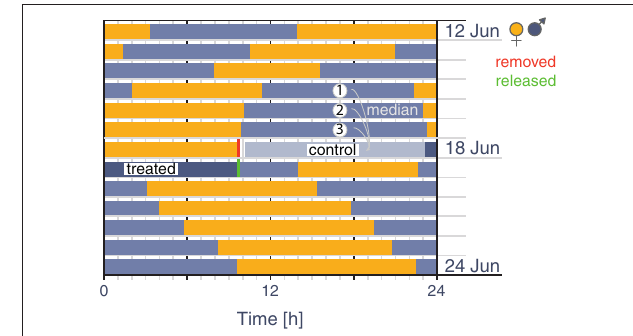
FIGURE 2 | Schematic illustration of the experimental procedure . Rectangles indicate incubation bouts of a pair (female: yellow, male: blue-gray). We removed an incubating parent (here, the female) in the middle of the incubation period (indicated by the red vertical line), shortly before we expected its partner (the focal parent; here the male) to return. After 24h we released the removed parent in the vicinity of its nest (the release time is indicated by the green vertical line). Thus, the focal parent incubated its “natural” incubation bout (“control” indicated by gray rectangle), defined as the period starting with the arrival of the focal parent on the nest and lasting for the length of the median incubation bout (estimated from the three previous incubation bouts of the focal parent). The remaining 12–13h (i.e., the time between the end of the control period and the release of the removed parent) define the “treated period” of the focal parent (indicated by dark blue